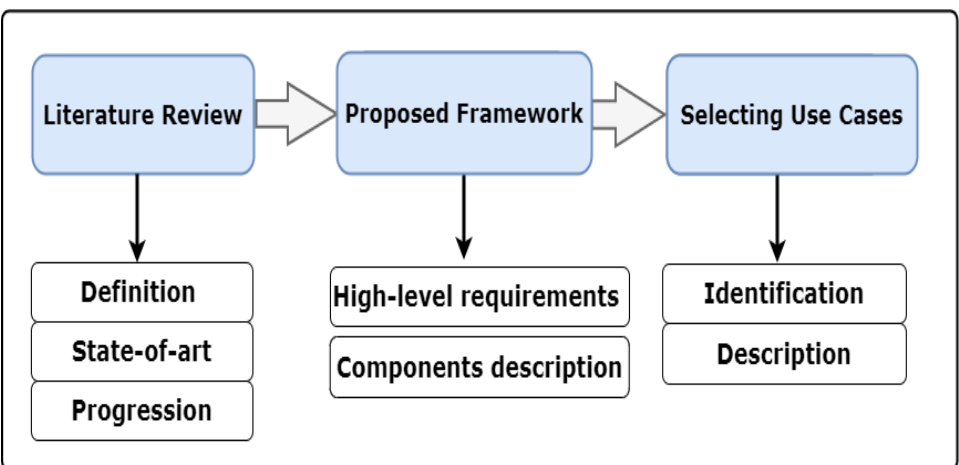
Figure 4. Overview of the research